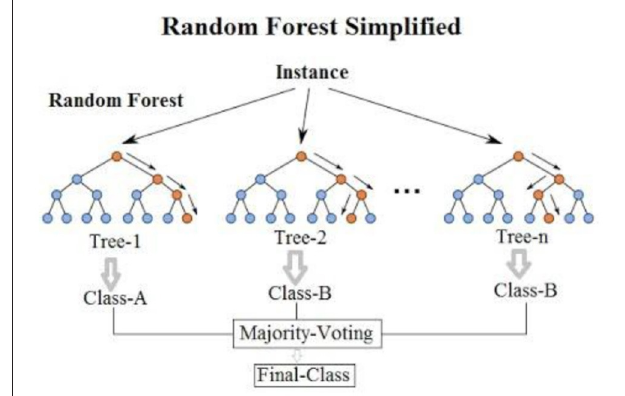
FIGURE 8 | A standard classification process for a RF algorithm. Source: Montantes